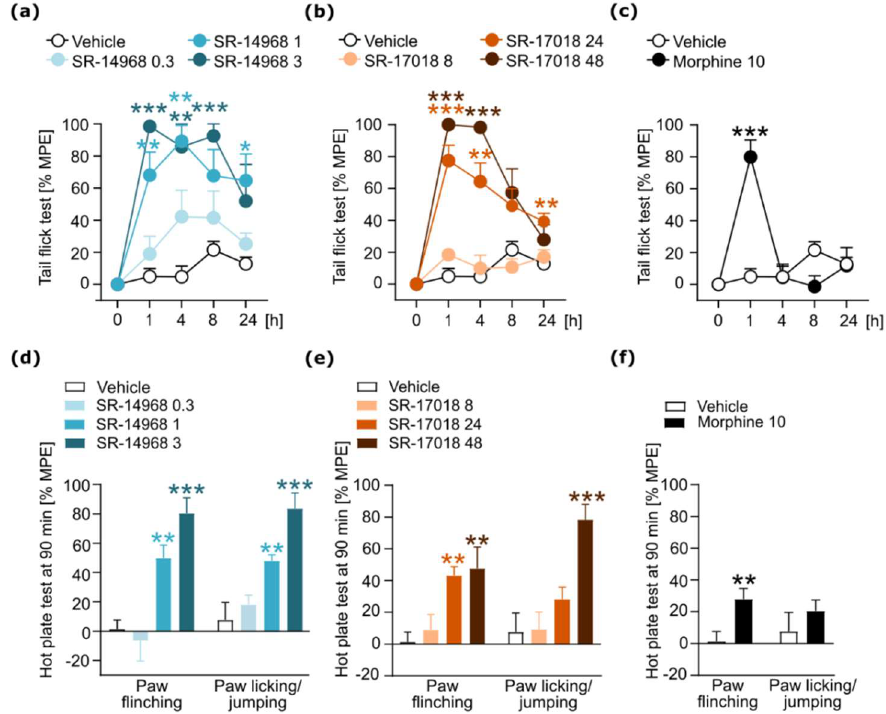
Figure 2. Antinociceptive effects of SR compounds in thermal nociceptive tests. ( a ) Administration of SR-14968 (0.3–3 mg/kg, i.p.) and ( b ) SR-17018 (8–48 mg/kg, i.p.) resulted in an attenuated sensitivity to painful stimulus in the tail flick test. ( c ) Administration of morphine (10 mg/kg, i.p.), used as a positive control, also caused antinociception in the tail flick test. ( d ) Treatment with SR- 14968 and ( e ) SR-17018 resulted in antinociceptive effects in the hot plate test. In this test, two types of reactions were assessed: paw flinching and paw licking/jumping. Those reactions were analyzed